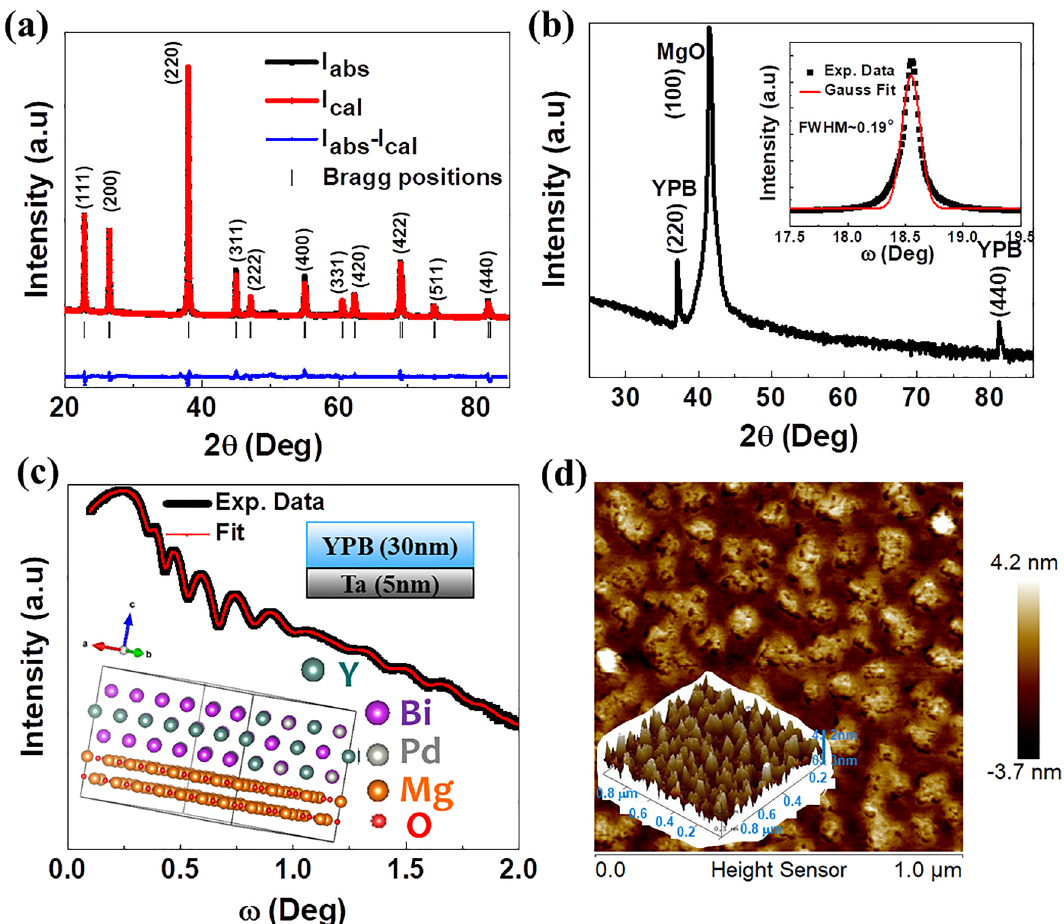
Figure 1. Structural characterizations of YPdBi: ( a ) Rietveld refinement of YPdBi powder XRD pattern. ( b ) Gonio mode XRD pattern of YPdBi thin film, inset shows rocking curve scan of (220) peak. ( c ) X-ray reflectivity scan of β-Ta (5 nm)/YPdBi (30 nm) and corresponding fitting curve in red color. Insets show the epitaxial relationship between (110) YPdBi and (100) MgO atomic layer. ( d ) Topographical AFM image, inset shows corresponding tilted 3D